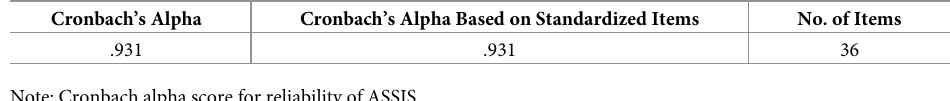
Table 3. Cronbach alpha score executed by SPSS